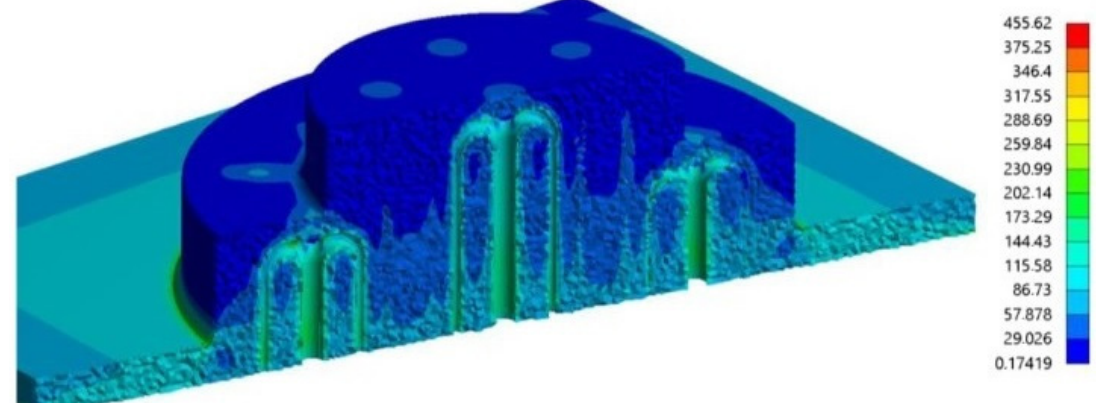
Figure 8. von Mises stress map [MPa] along the core plate insert, Reprinted with permission from [35], 2019, Mercado-Colmenero et al. [35].